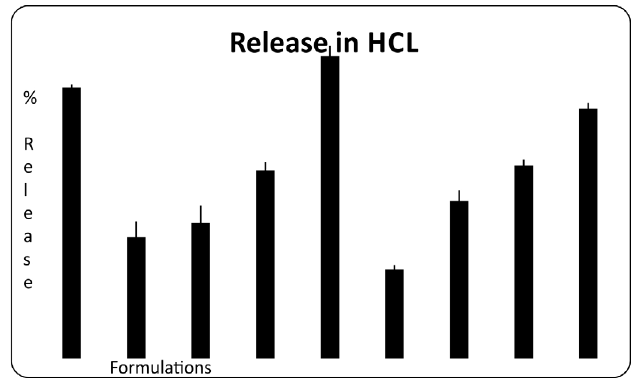
FIGURE 6 - Comparative results of in vitro release profile of different proportions of SA, CH, and SCMC beads of sodium diclofenacin hydrochloric acid buffer pH